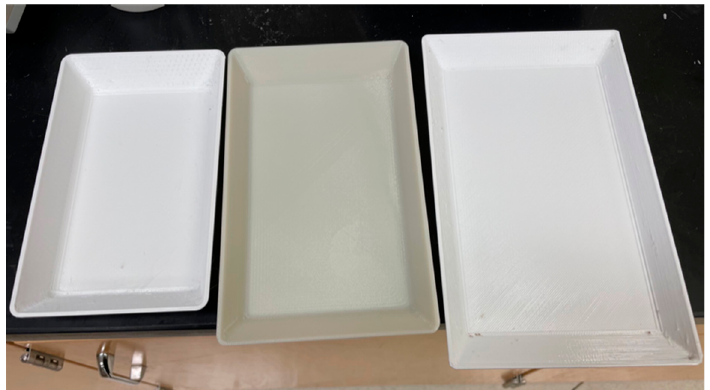
Figure 6. 3D-printed rectangular trays with one optimized thickness (middle, 1.56 cm) and two non-optimized thicknesses (left 2.00 cm and right 1.20 cm).